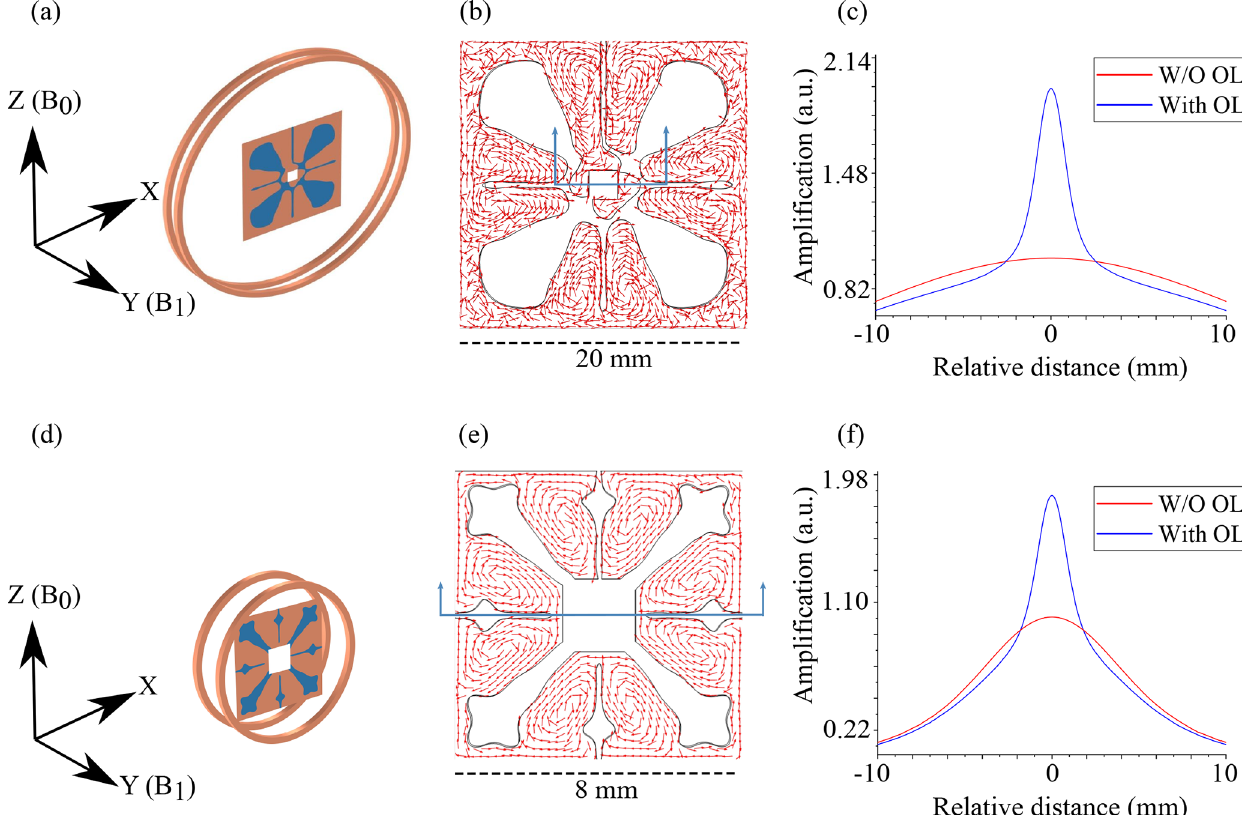
Figure 4. The setup used for characterizing the OL: (a) 45MHz and (d) 500MHz. The OLs were placed at the centre of two conductive rings such that the magnetic field ( B 1 ) produced by the coil is normal to its plane. B 0 represents the direction of the static magnetic field to visualize the orientation of the arrangement when placed in the MR machine. (b, e) show the currents induced in the OL. (b) From the current flow, it can be interpreted how the magnetic flux would be concentrated at the (cid:127) T , while the current flowing on copper protrusions ensures the uniformity of the magnetic field. (e) At 500MHz due to stronger inductive coupling, the amplification produced is high; therefore, the optimization results in a symmetric material distribution in order to maintain the uniformity while at the same time ensuring a desired current flow for the field amplification. (c, f) Amplification produced by the OLs, plotted along the direction of B 1 . The distance represents relative values from the centre point of the OLs. Table 2. Comparison summary between the OL and the LL. For the LL, the values in brackets represent the ratio of the outer to the inner diameter. Lens Frequency Amplification Variation in (cid:127) T Variation along L z and L x LL(5.59) 45MHz Optimized